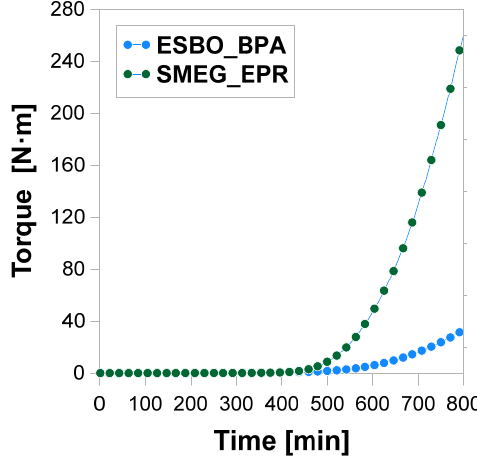
Figure 10. Torque as a function of processing time.